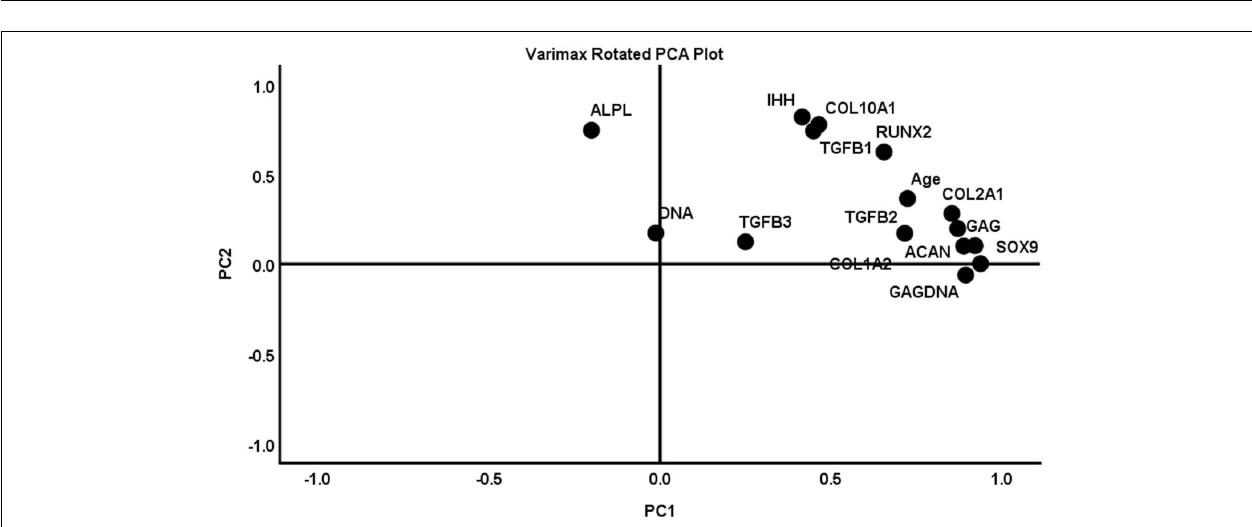
Frontiers in Cell and Developmental Biology |